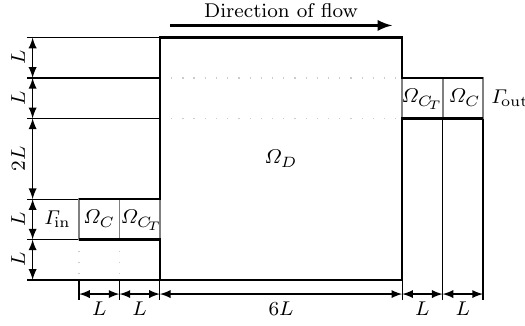
Figure 3. The computational domain Ω for the Tesla